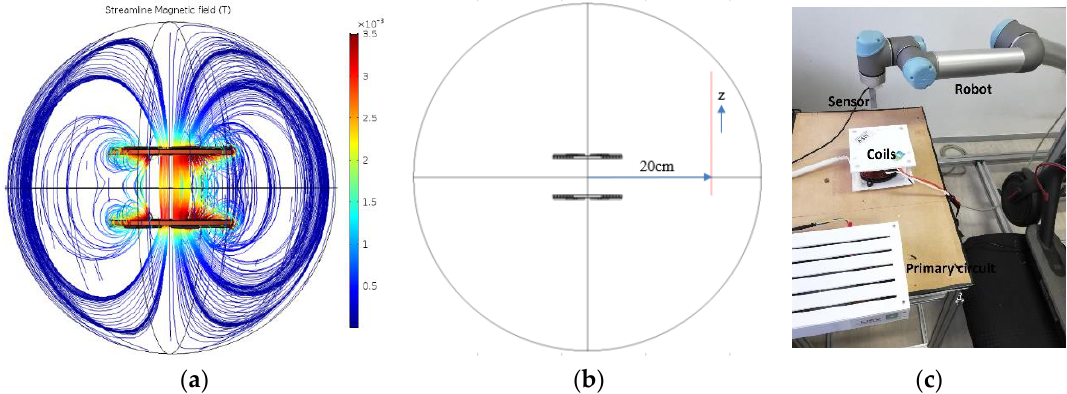
Figure 4. ( a ) Magnetic field streamline and its flux density in tesla (T) of 160 W wireless charging system at 30 kHz; ( b , c ) simulation and experimental models to measure the B rms of the magnetic flux density.